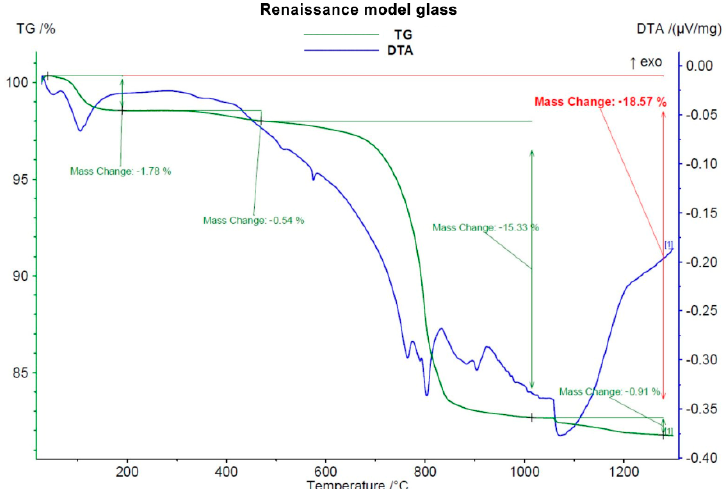
Figure 2. Course of DTA-TG analysis of Renaissance model glass.